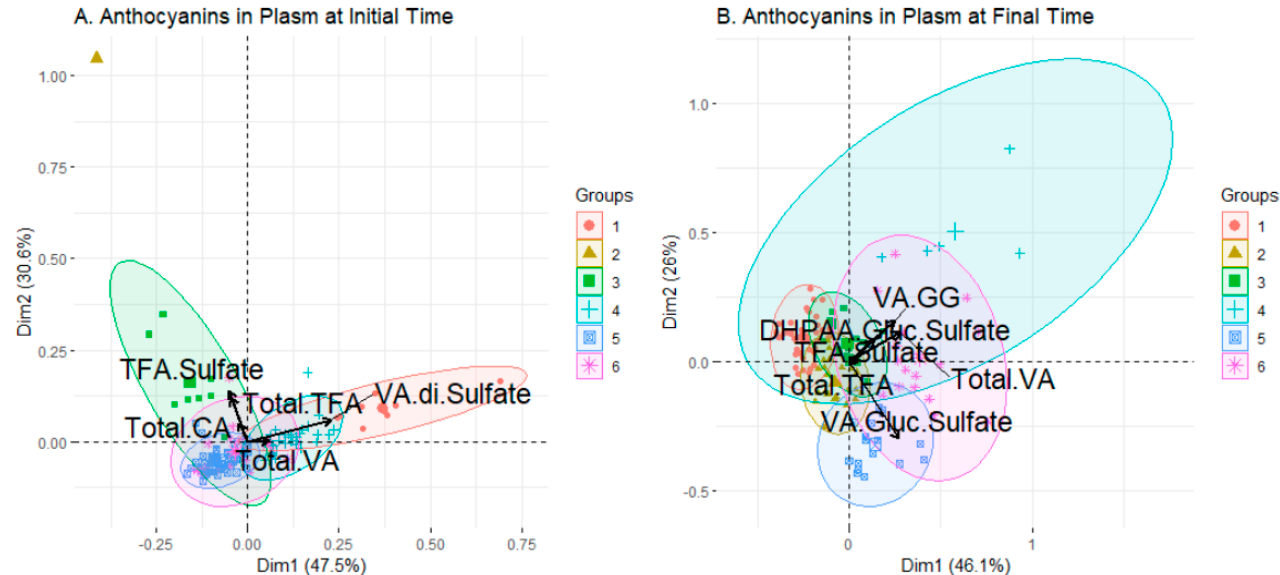
Figure 3. Biplot of the groups generated by clustering analysis applied to anthocyanin data set before ( A ) and after ( B ) consumption of the beverage. In black, the arrows showing the contribution to the composition of the clusters of the variables.